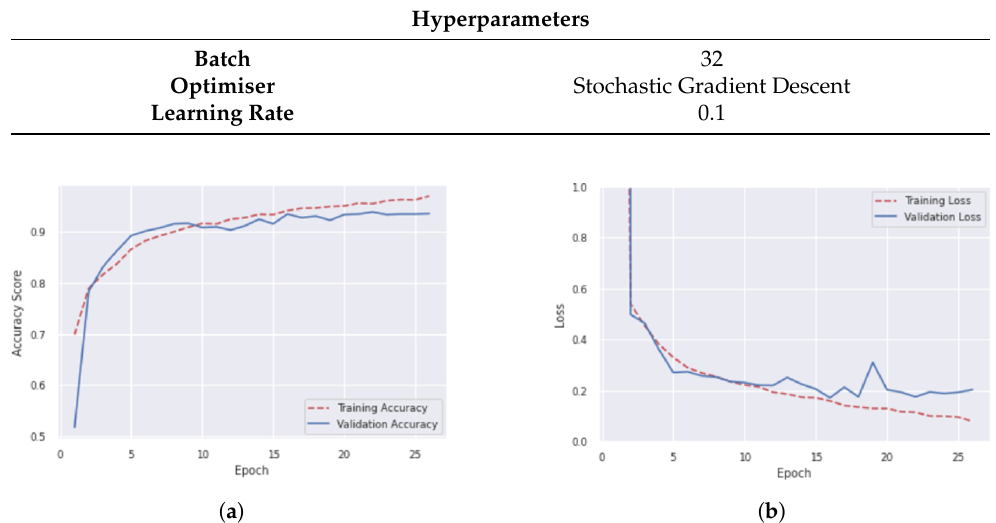
Figure 8. The learning curves of mean training and validation accuracies ( a ) and mean training and validation losses ( b ) during training of the best ResNet50 model. The model was trained on 10,000 images of the proposed colouring scheme that had been processed with an α -cut of